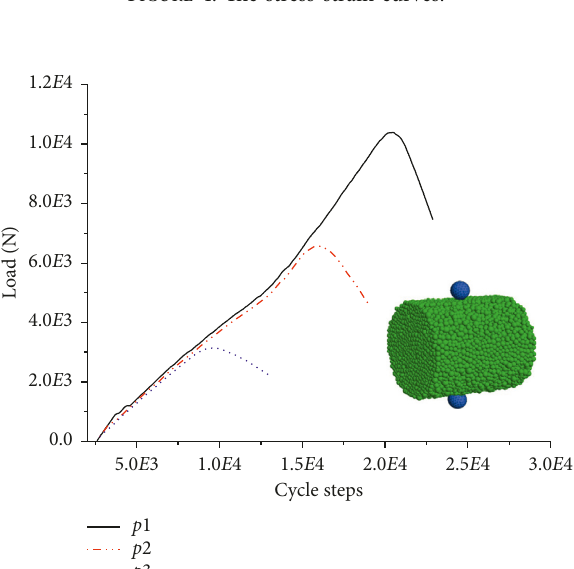
Figure 4: The stress-strain curves.